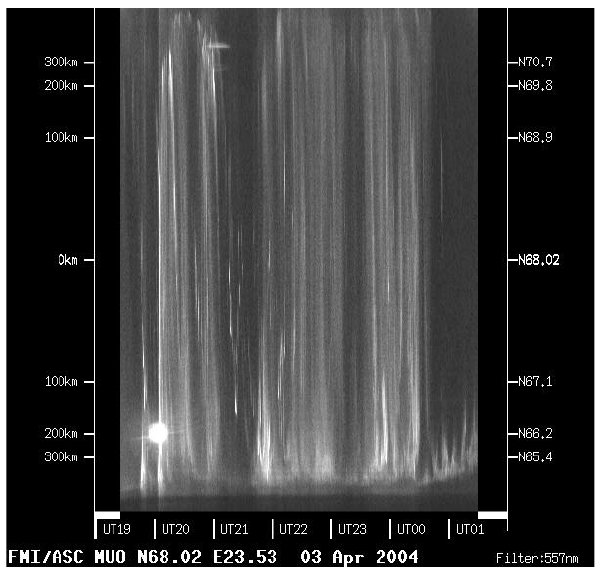
Fig. 1. ASC keogram from Muonio on 3 April